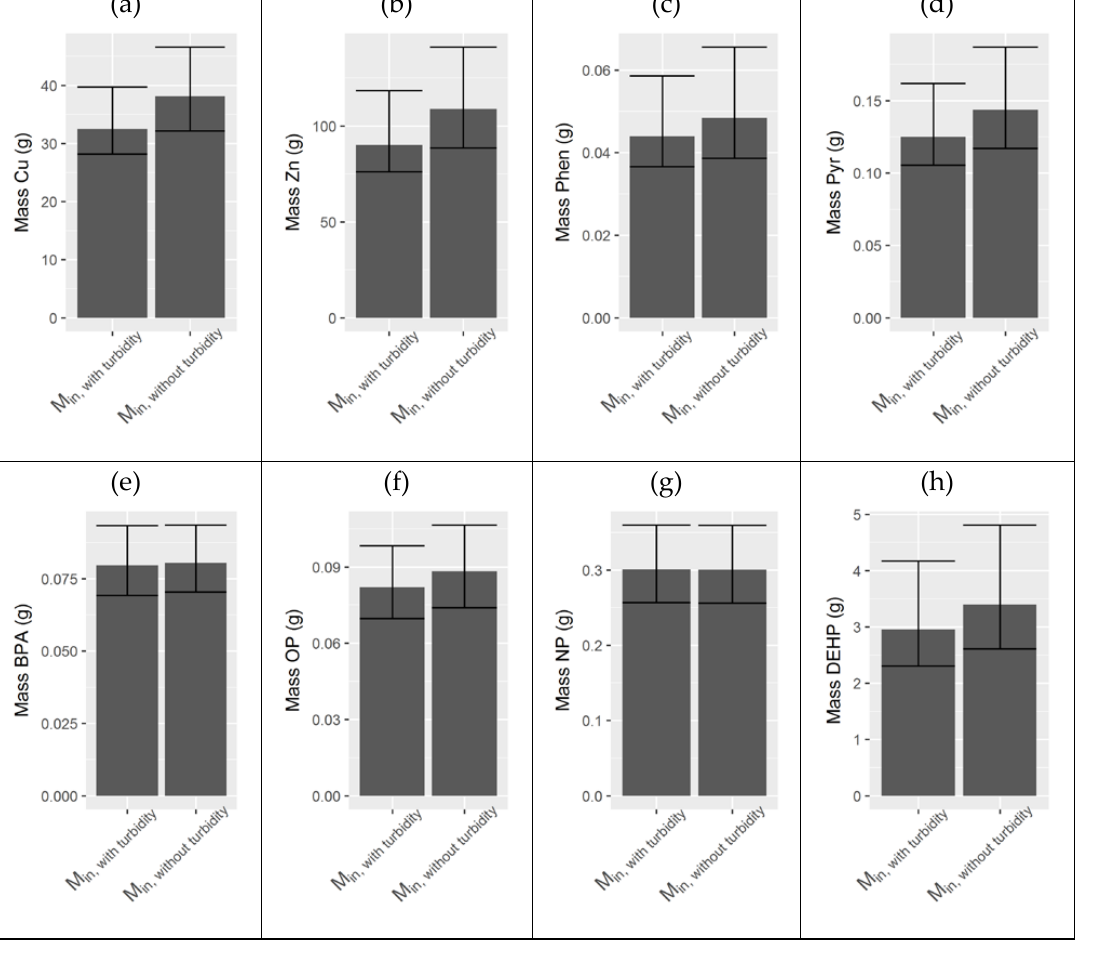
Figure F1. Comparison of inlet mass calculations with and without turbidity data for ( a ) copper, ( b ) zinc, ( c ) phenanthrene, ( d ) pyrene, ( e ) bisphenol-A, ( f ) octylphenol, ( g ) nonylphenol and ( h ) bis(2-ethylhexyl) phthalate. Bars represent medians, while error bars represent the 95% confidence interval.